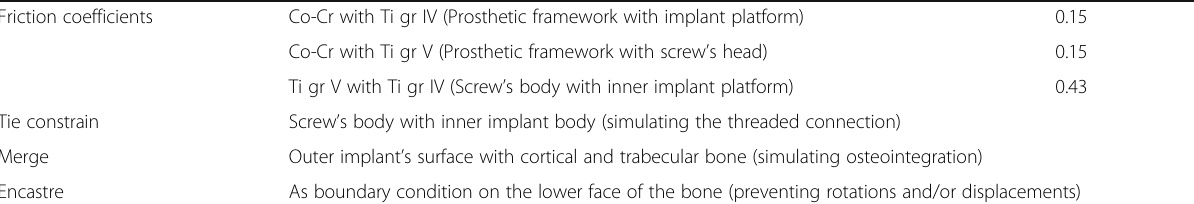
Table 3 Interactions and boundary conditions elected for the present study Friction coefficients